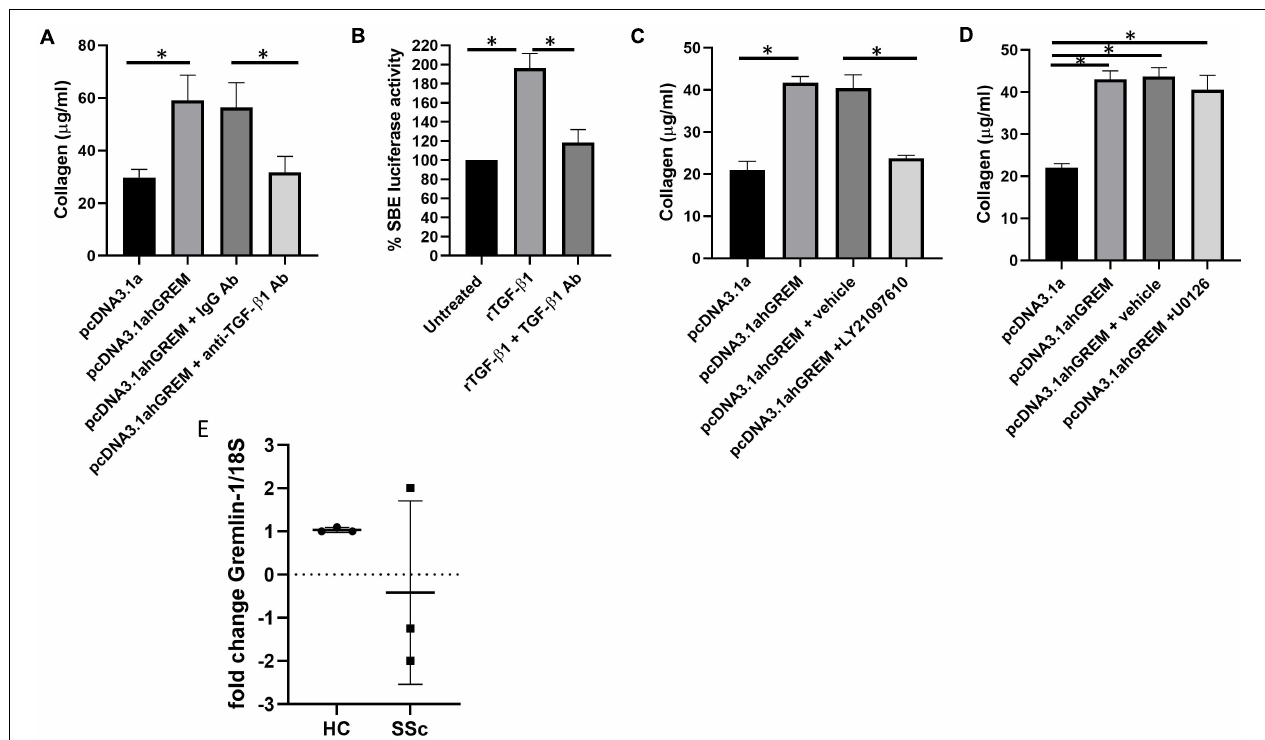
FIGURE 6 | Gremlin mediates its effects through TGF- β /Smad signaling. (A) Collagen is reduced by TGF- β 1 neutralizing antibody. Cells were treated with isotype matched antibody or TGF- β 1 neutralizing antibody and either empty pcDNA3.1a or pcDNA3.1a-hGREM. ∗ Significantly different P = ANOVA pcDNA3.1 vs pcDNA3.1a-hGREM. * P = pcDNA3.1a-hGREM vs. pcDNA3.1a-hGREM and TGF- β 1 antibody. (B) TGF- β 1 neutralizing antibody reduced SBE luciferase in fibroblasts P ≤ 0.001 rTGF- β 1 vs. rTGF- β 1 and neutralizing antibody. (C) Collagen is reduced with LY2109761 with gremlin-1 overexpression. (D) U0126 ERK (10 µ M)